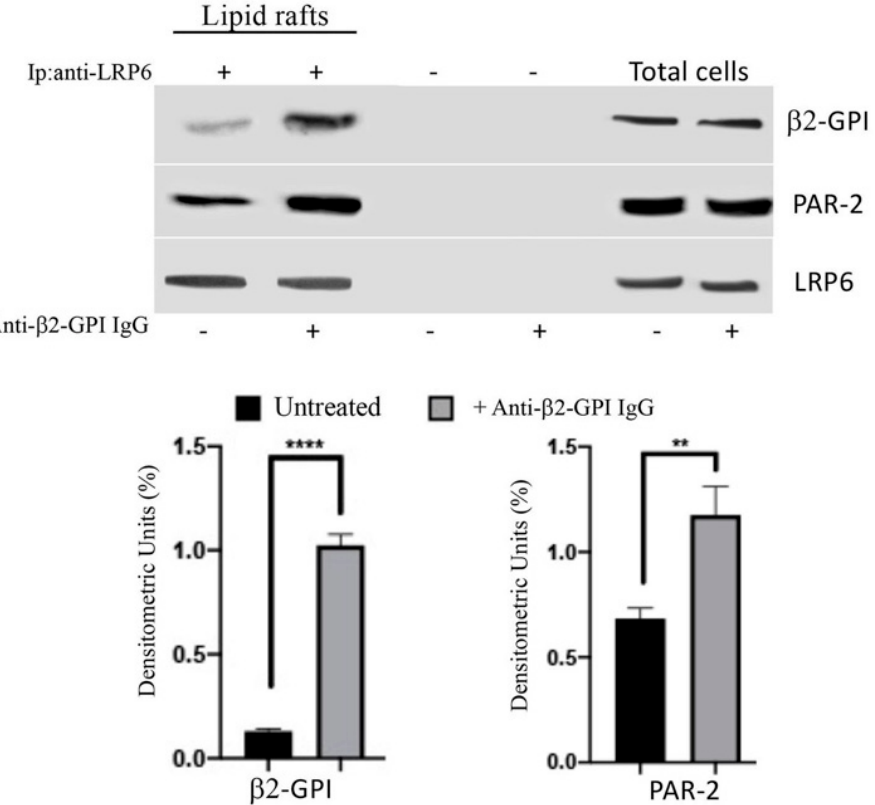
Figure 4. β 2-GPI-LRP6-PAR-2 association within lipid rafts following triggering with anti- β 2-GPI antibodies. Pooled Triton X-100-insoluble fractions (4–5–6), obtained from HUVECs cells, untreated or treated with affinity-purified anti- β 2-GPI antibodies for 45 min at 37 ◦ C, were immunoprecipitated with goat anti-LRP6 Abs. The immunoprecipitates were subjected to 10% SDS-PAGE. Membranes were probed with anti-PAR-2 mAb or with anti- β 2-GPI Ab. As a control, immunoprecipitates were assessed by immunoblot with rabbit anti-LRP6 mAb. Results represent the mean ± SD from three independent experiments. ** p < 0.005, **** p < 0.0001.